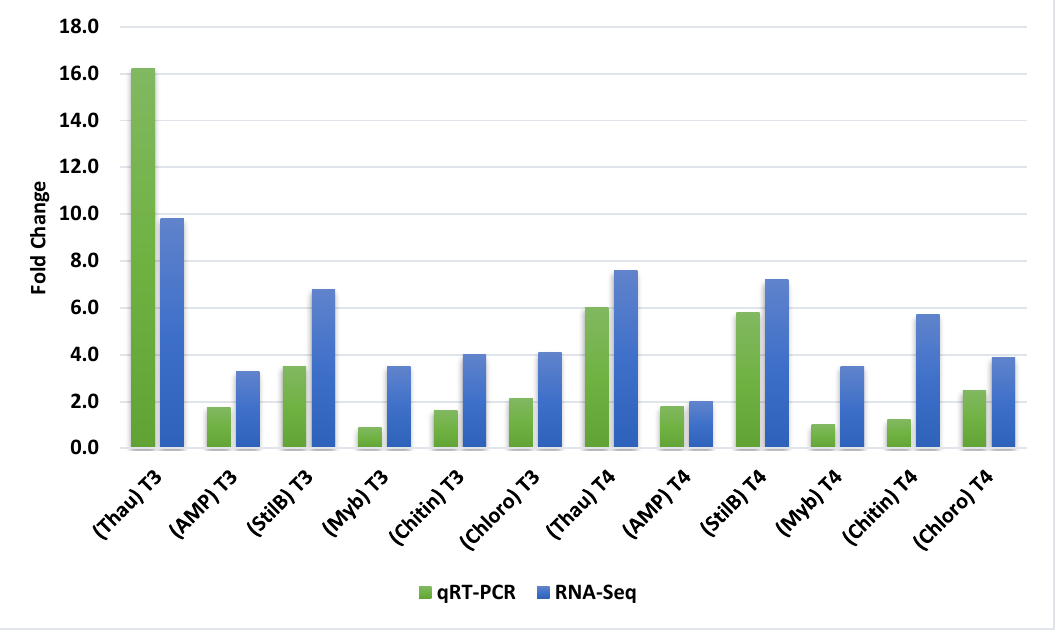
Figure 2. Fold Change for each of the transcripts selected for validation. The values are represented as the Log2 of the normalized expression value of both RNA-sequencing (RNA-Seq) and quantitative real-time polymerase chain reaction (qRT-PCR) data at time points Py3—48 h and py4—7 days. Linear regression analysis showed significantly positive correlation (R2 = 0.7032) between RNA-Seq and qRT-PCR in the fold change of the gene expression ratios (Figure 3), indicating that the results obtained by qRT-PCR agreed well with the ones obtained with DGE analysis.